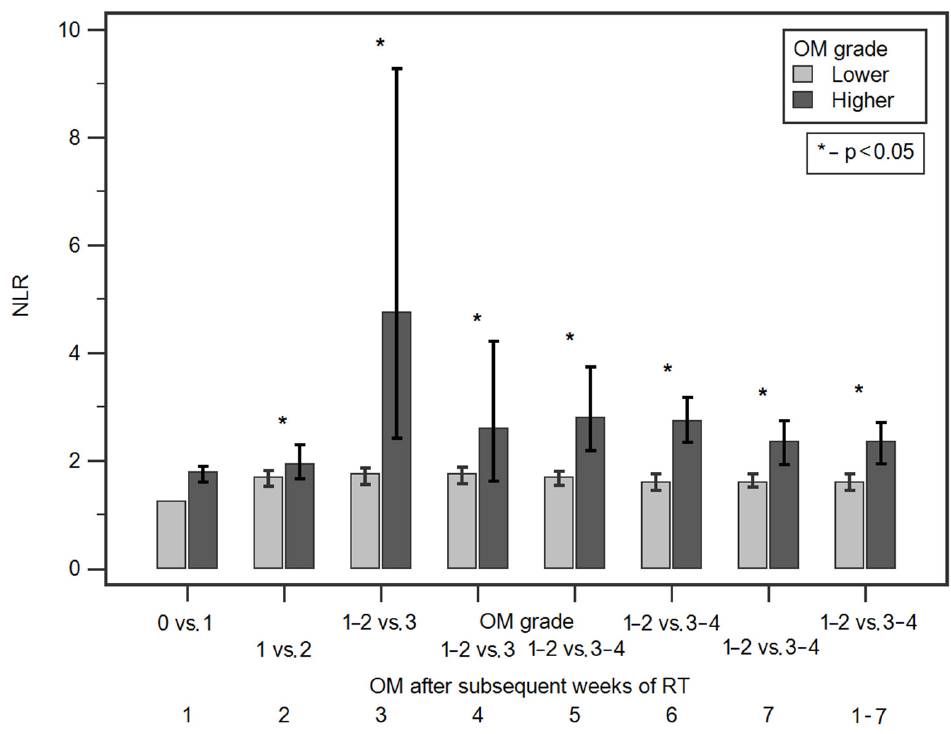
Figure 1. Comparisons of NLR values according to OM grade in subsequent weeks of RT.